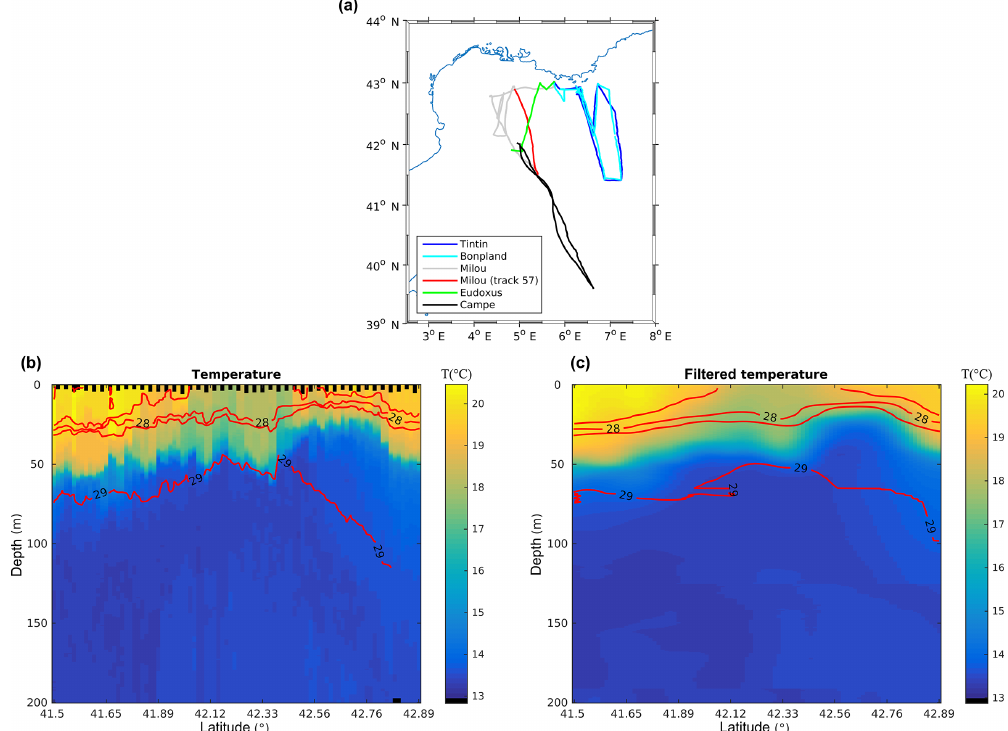
Figure 5. (a) Location of the different gliders used in this analysis. In red, the glider Milou section (155km long) along the SARAL altimeter track 57 from 27 October to 3 November 2014. (b) Vertical temperature section from the Milou glider over the upper 200m. (c) Filtered temperature section with cutoff at 30km